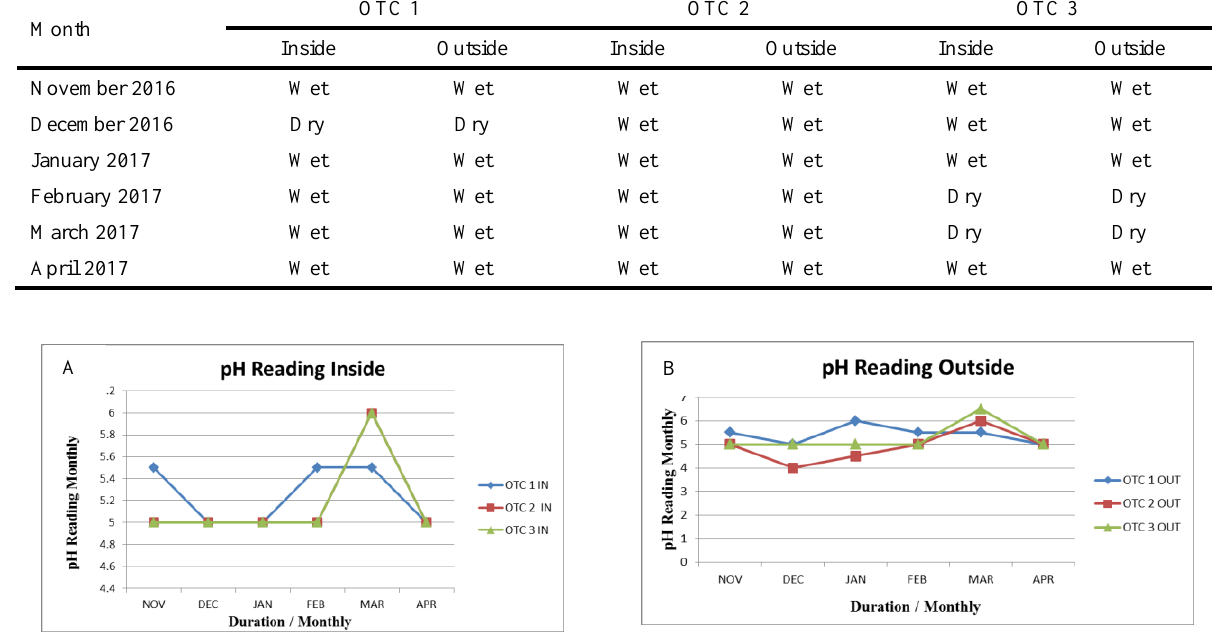
Table 1: The Soil’s OTC Moisture Reading for 3 Different Units